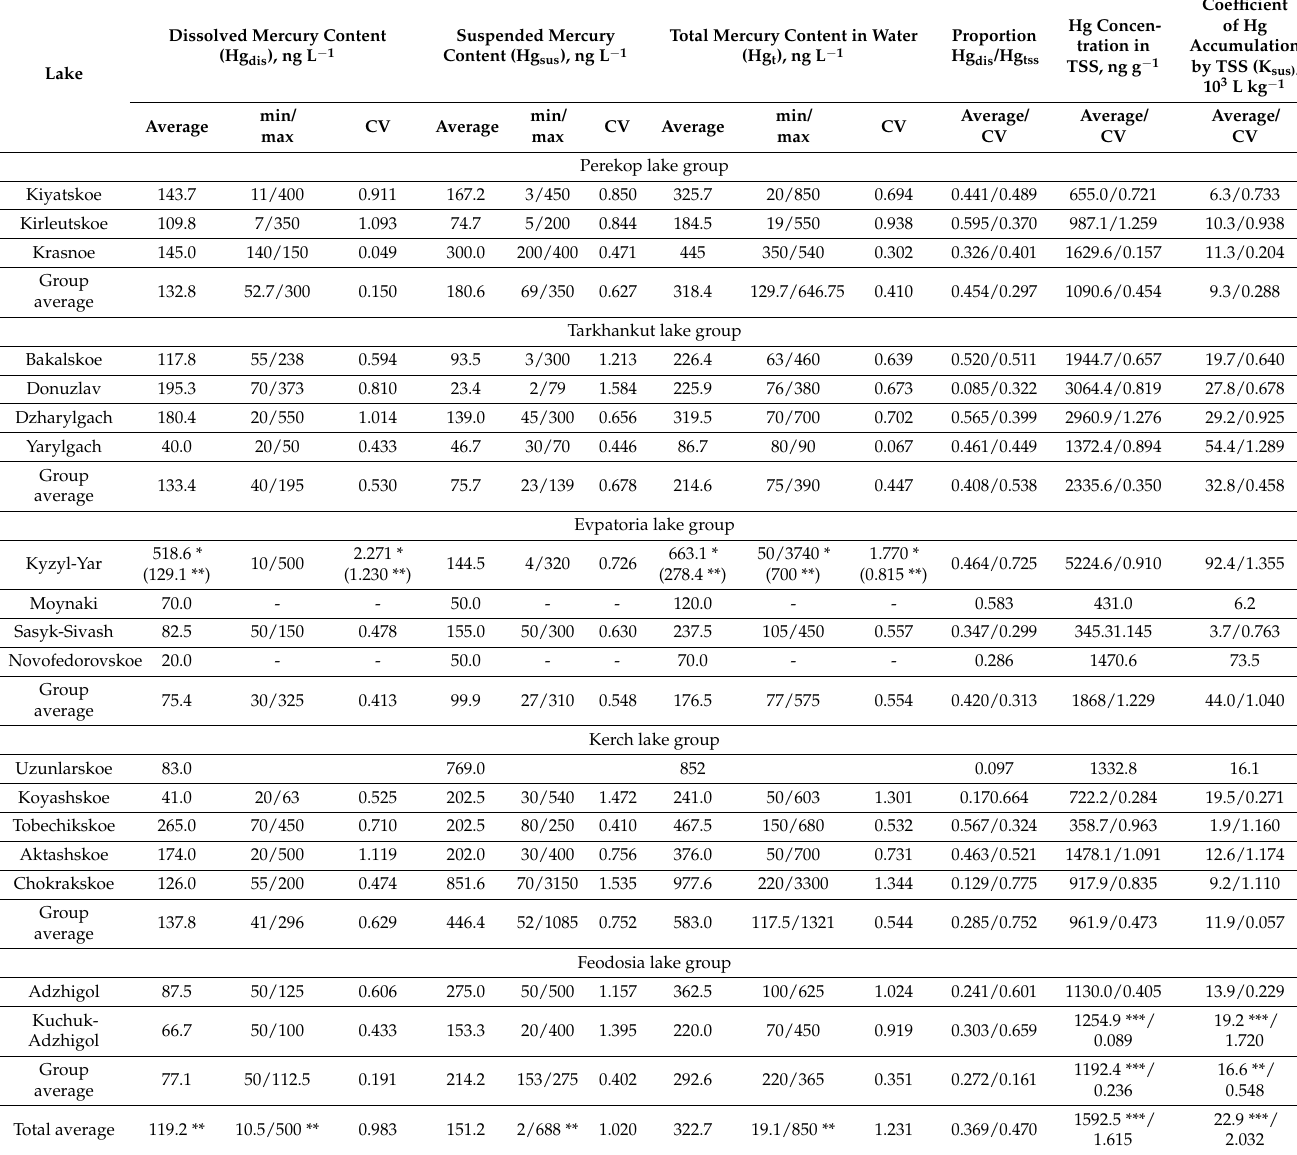
Table 2. The dissolved and suspended Hg content in the Crimean saline